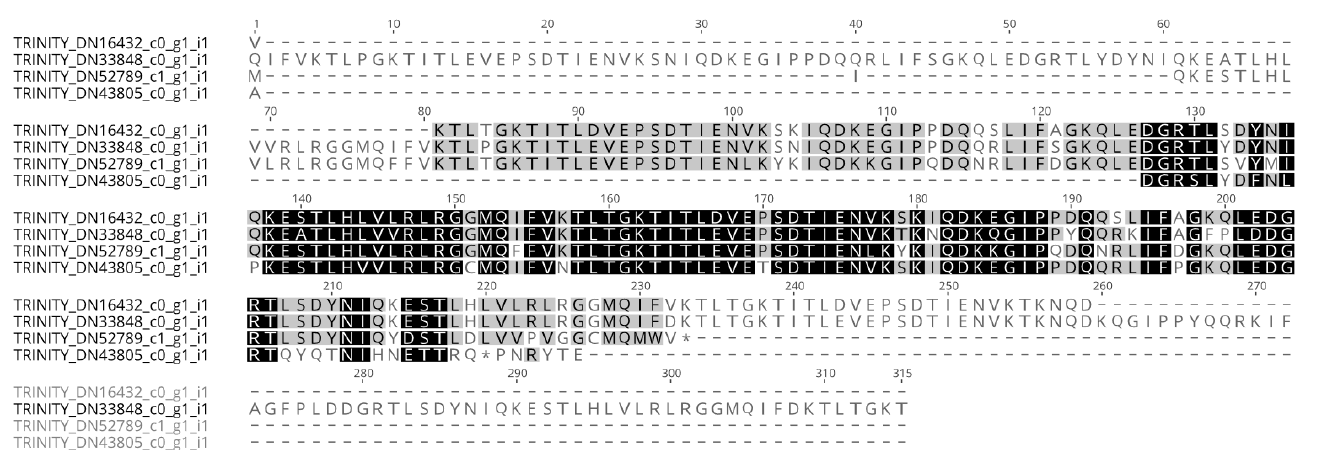
Figure 5. Alignment of the translated ORFs of the four distinct transcripts from the H. glaberrima RNC transcriptome that matched ubiquitin.